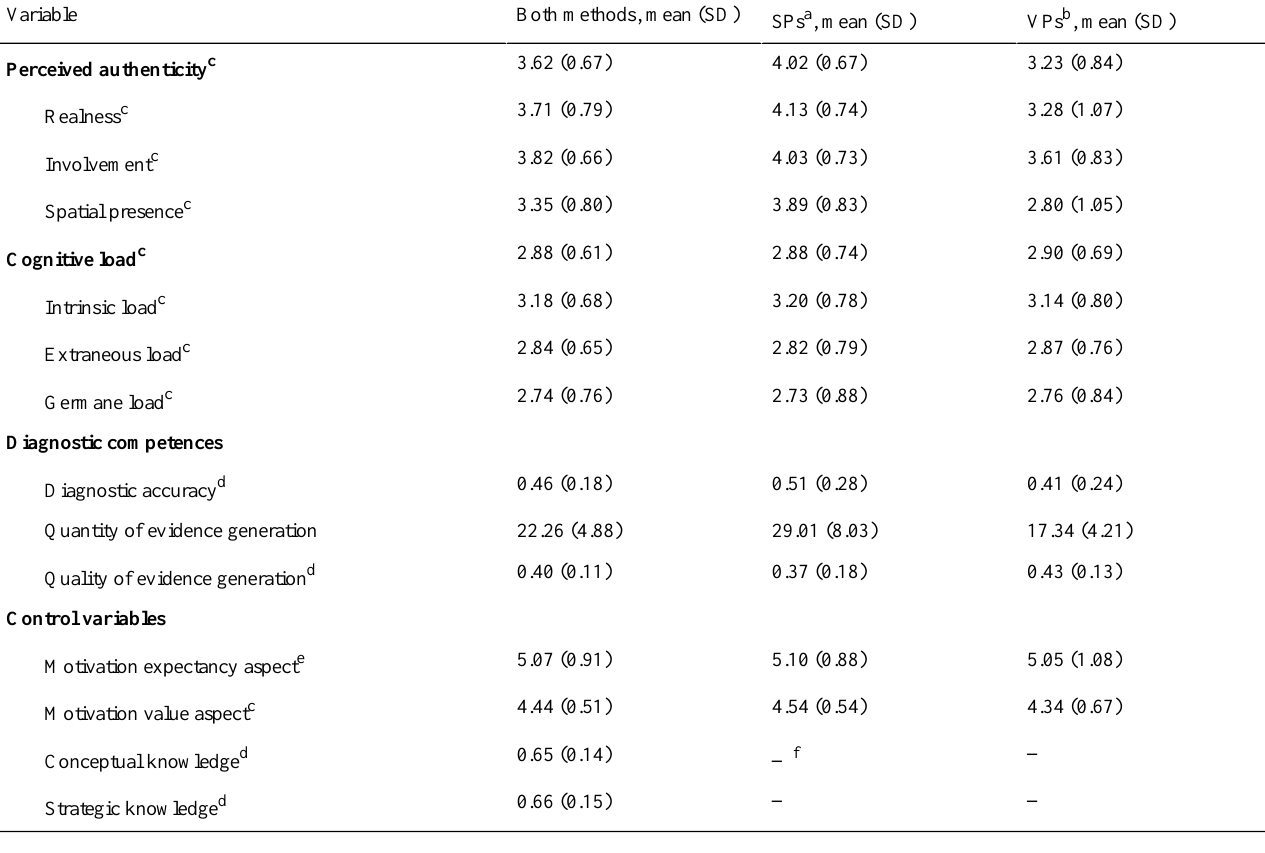
Table 3. Descriptive